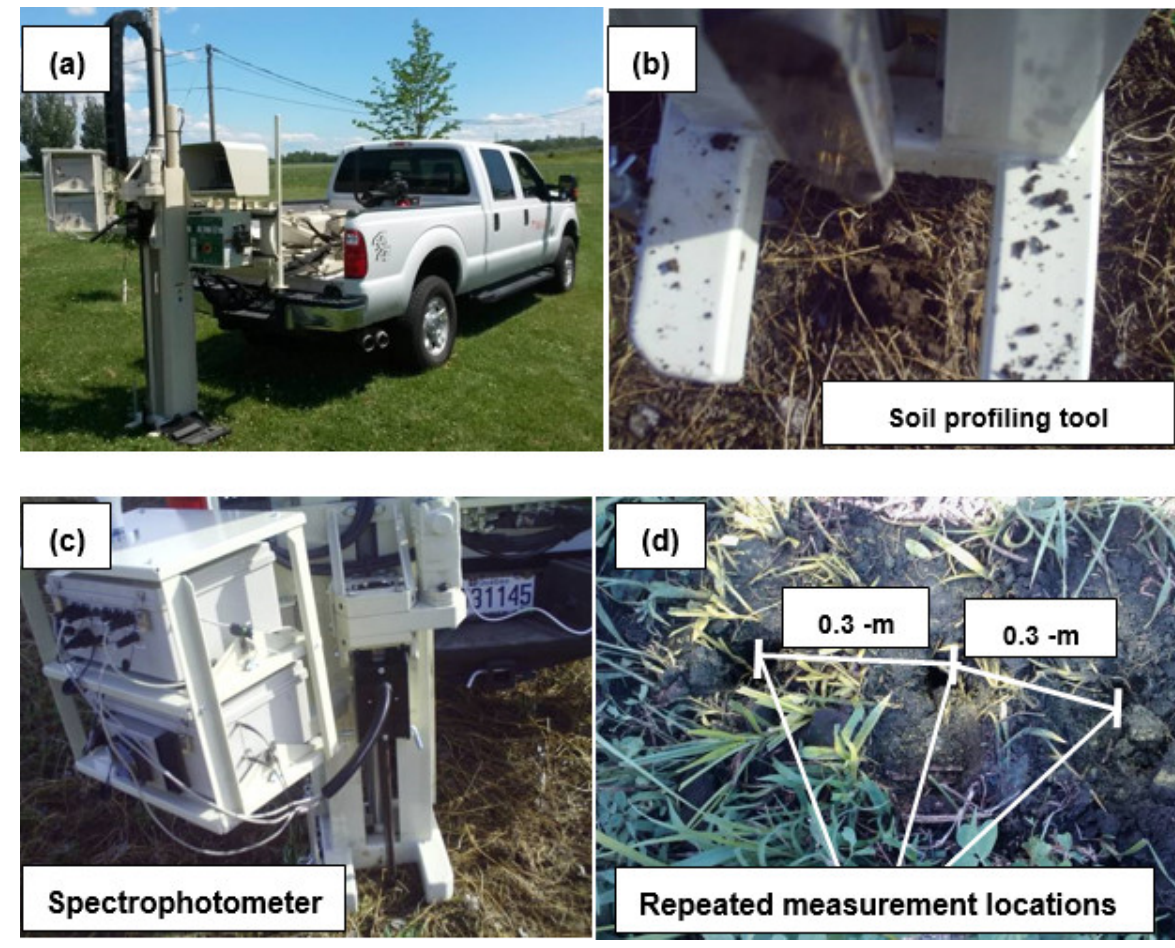
Figure 4. Illustration of the vis–NIR soil profiling tool during in situ measurements (pickup truck mounted instrument ( a ), soil profiling tool ( b ), both spectrometers inside the enclosures ( c ) and repeated measurement locations ( d )).